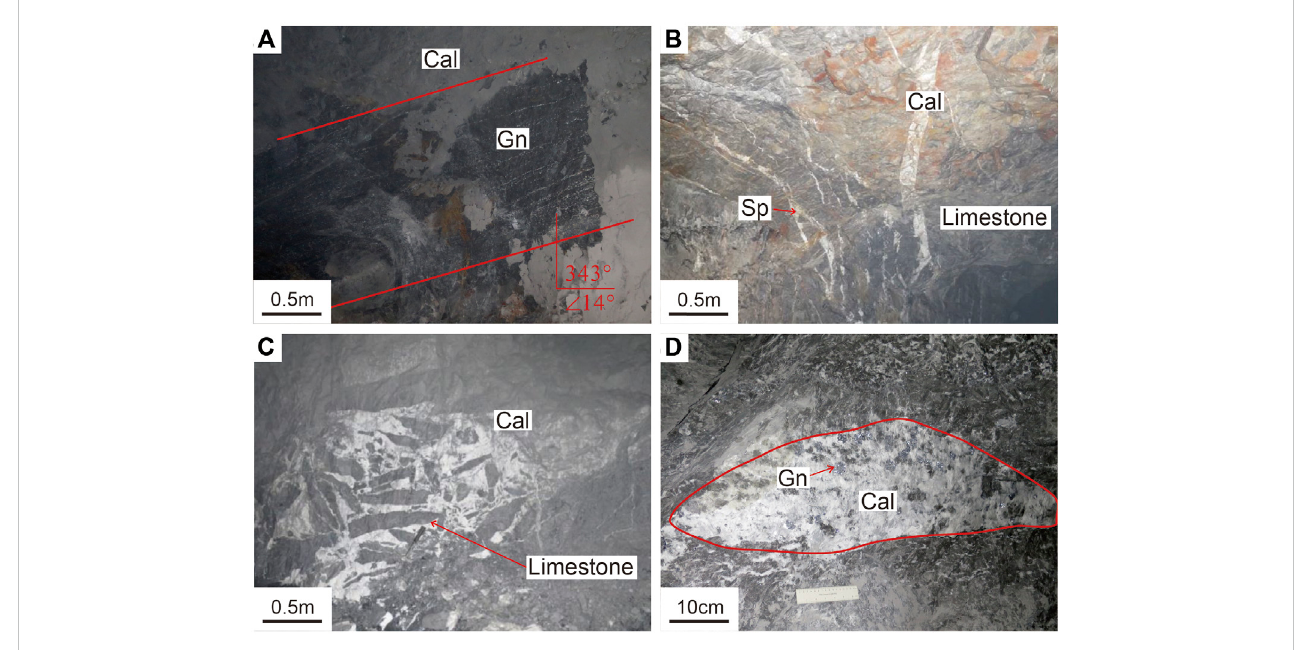
Different types of orebodies in the Huayuan Pb-Zn ore fi eld: (A) layered, (B) veined, (C) breccia, and (D) lenticular